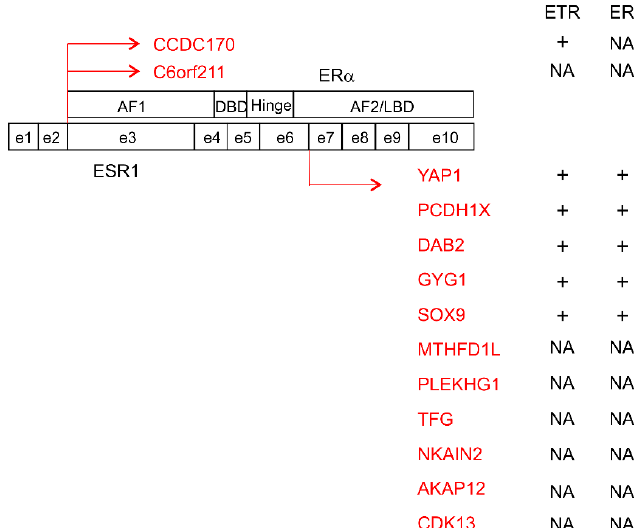
Figure 4. ESR1 fusion genes detected in patients with ETR breast cancers. The exons (e1–e10) of the ESR1 gene and the domain structure of ER α are shown. The fusion of e2 and e6 to the indicated